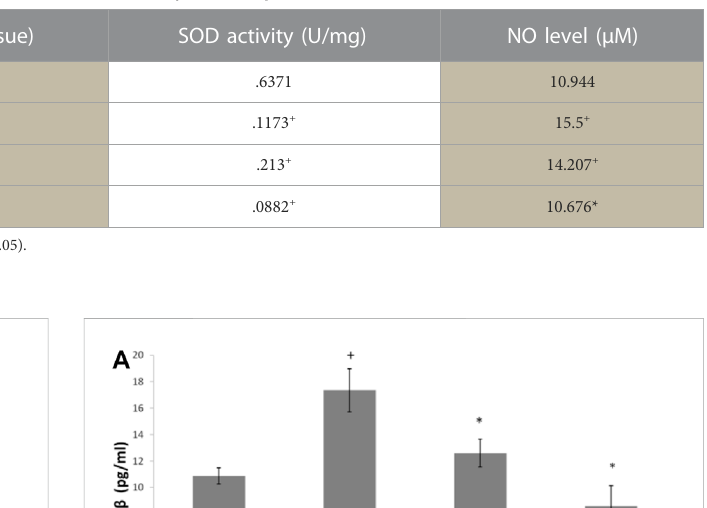
TABLE 2 The effect of P. sarmentosum and omeprazole on MDA and NO levels and SOD activity in rats exposed to WIRS for 3.5 h.